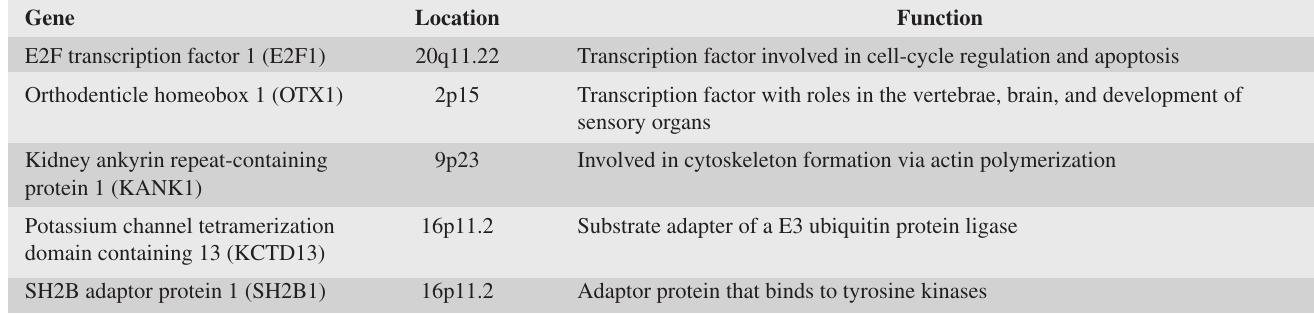
Table 2. Gene Mutations and Copy Number Variants and Their Known Associations with Male Genitourinary Birth Defects Gene Location Function E2F transcription factor 1 (E2F1) 20q11.22 Transcription factor involved in cell-cycle regulation and apoptosis Orthodenticle homeobox 1